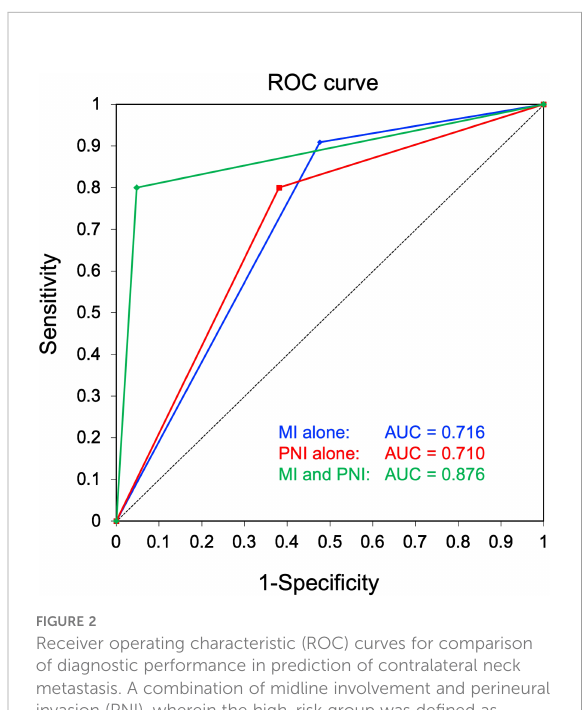
FIGURE 2 Receiver operating characteristic (ROC) curves for comparison of diagnostic performance in prediction of contralateral neck metastasis. A combination of midline involvement and perineural invasion (PNI), wherein the high-risk group was de fi ned as showing both midline involvement and PNI, while the low-risk group comprised the remaining patients without midline involvement and/or PNI, showed a superior area under the curve (green, 0.876) to that of midline involvement alone (blue, 0.716) and PNI alone (red,